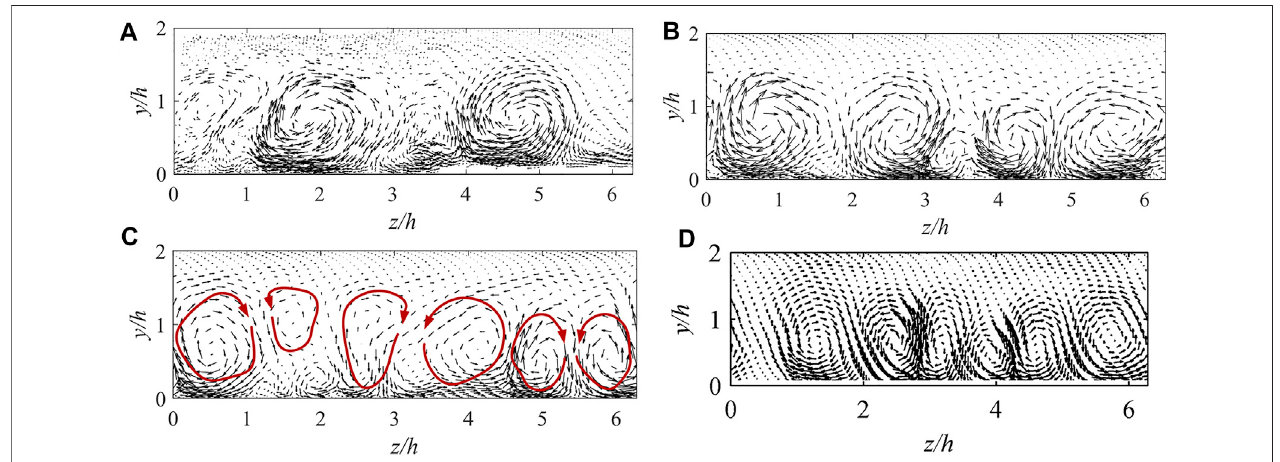
FIGURE 9 | Comparison of Taylor – Götler vortices at Ro = 0.3: (A) SST k- ω PANS-ES1, (B) SST k- ω PANS-ES2, (C) SST k- ω PANS-RCES, and (D) DNS.